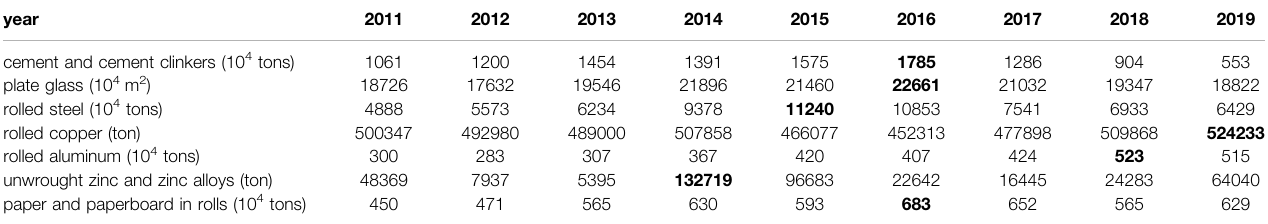
TABLE 2 | Exports of some energy-intensive products in China during 2011 –